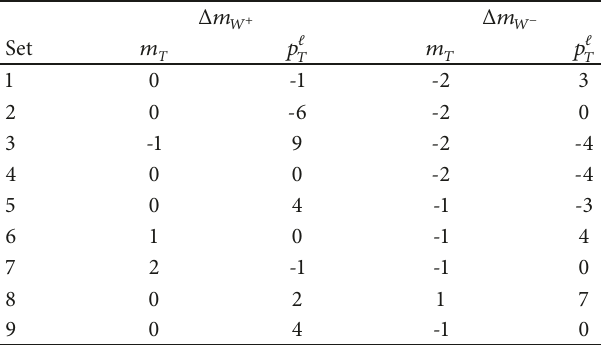
Table 3: Shifts in 𝑚 𝑊 ± (in MeV) induced by the corresponding sets of flavour-dependent intrinsic transverse momenta outlined in Table 2 (statistical uncertainty: